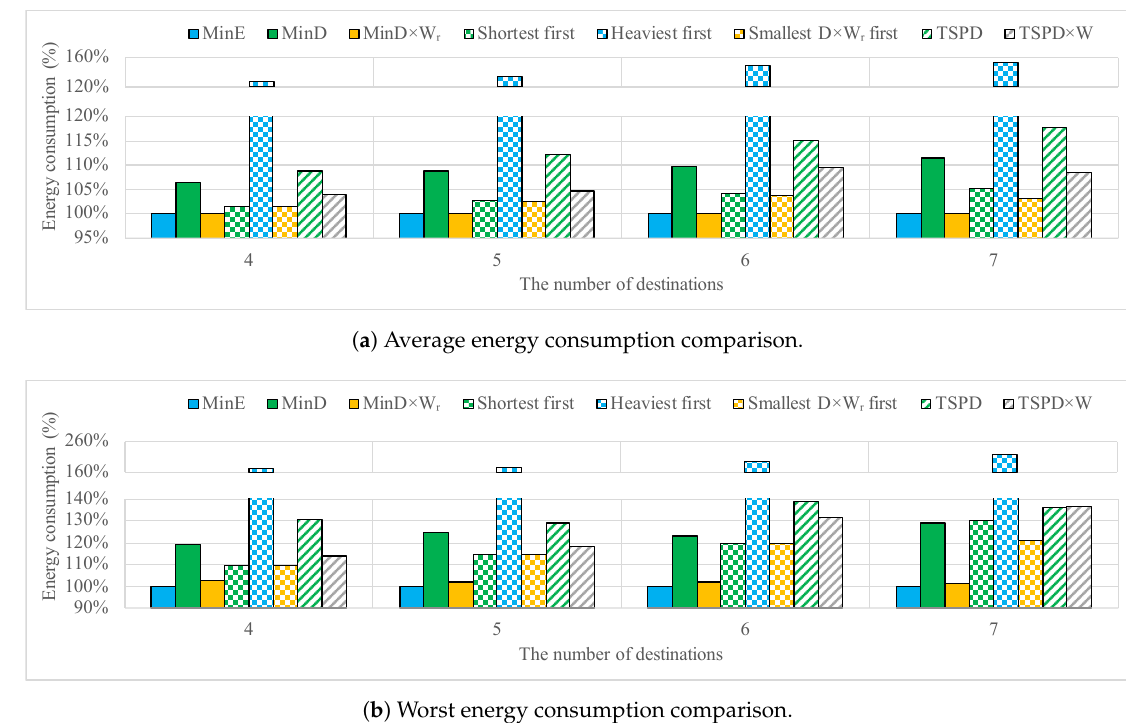
Figure 7. Energy consumption for different metrics (exhaustive exploration).